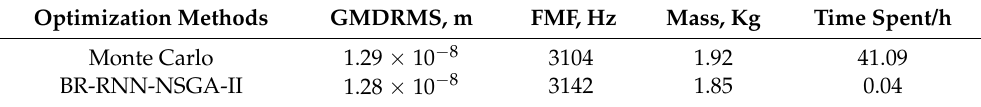
Table 7. Comparison of results and time spent between BR-RNN-NSGA-II and Monte Carlo method. Optimization